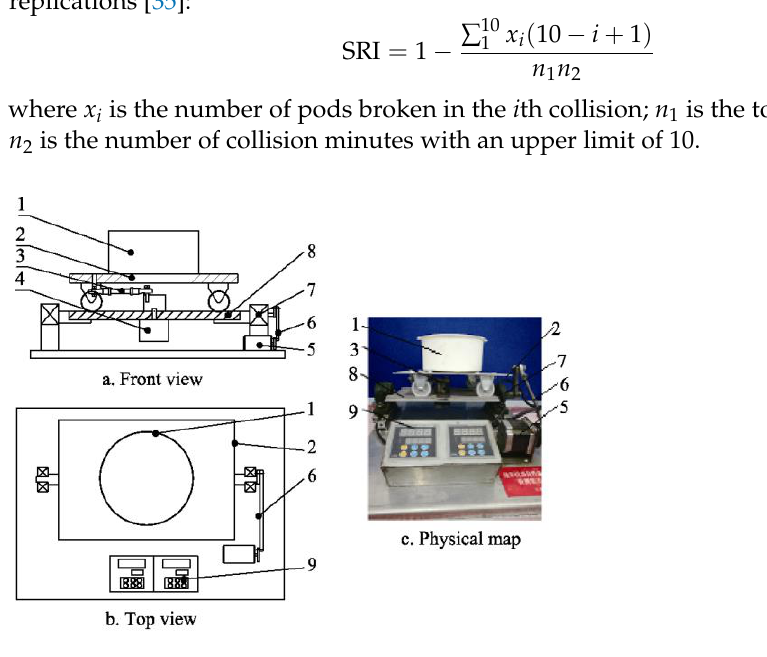
Figure 1. Structure and physical diagram of the 2-degree-of-freedom collision tester. ( a ) Front view of the tester; ( b ) Top view of the tester; ( c ) Physical map of the tester. 1. Material box, 2. Upper plate, 3. Crank slide mechanism, 4. Motor 2, 5. Motor 1, 6. Crank rocker mechanism, 7. Bearing, 8. Lower plate, and 9. Controller.